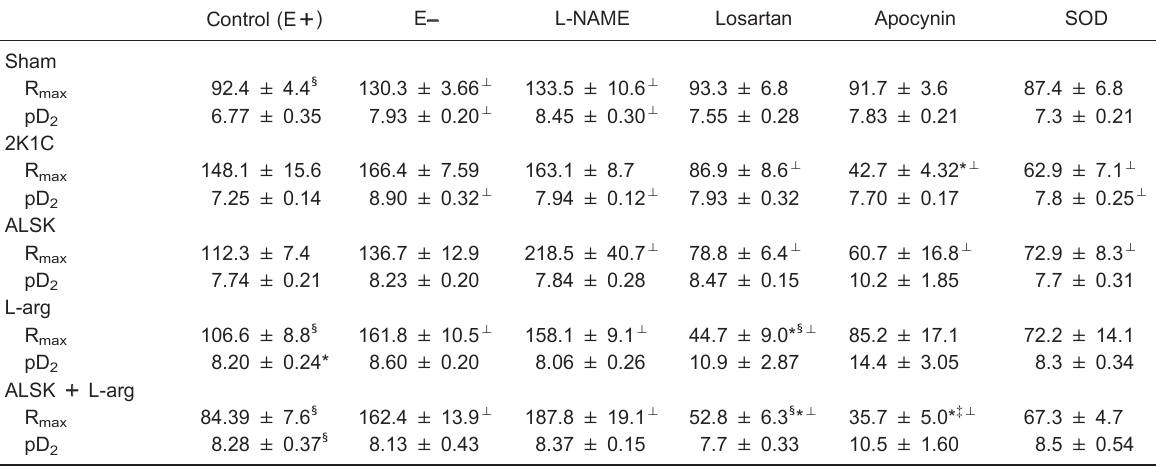
Table 1. Parameters of maximal response (R max ) and sensitivity (pD 2 ) of the concentration-response curves to phenylephrine in the aortas from all experimental groups, before (E++) and after endothelial denudation (E––) and after incubation with L-NAME (100 m M), losartan (10 m M), apocynin (0.3 nM) and SOD (150